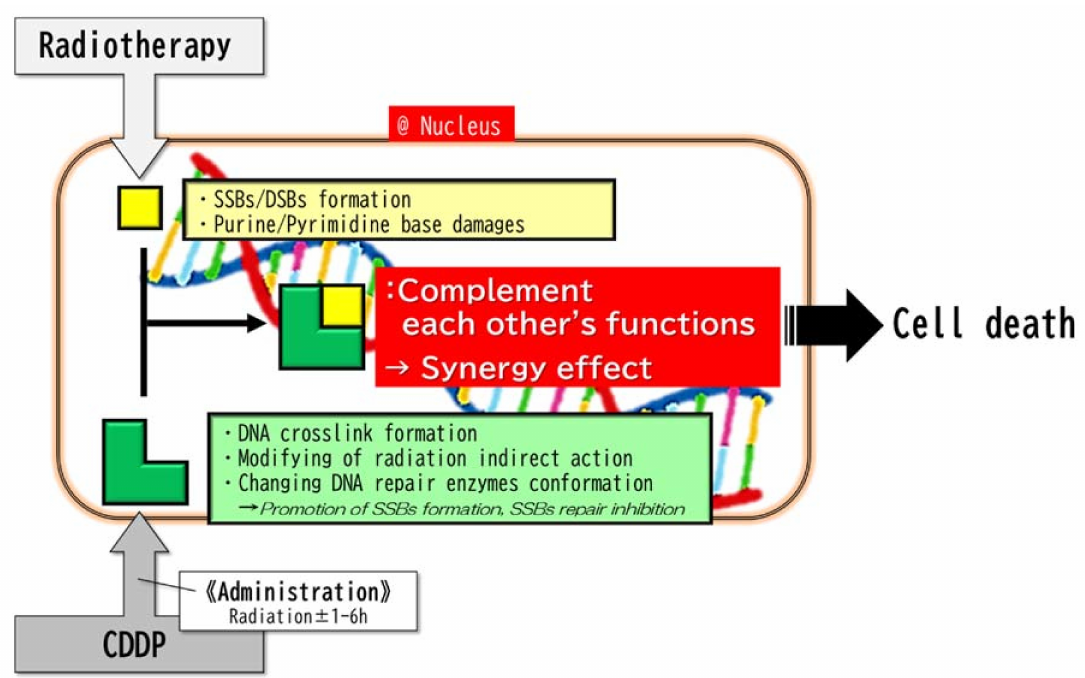
Figure 3. Minor reactions. The minor reactions take place in the nucleus. The complementary combination of radiation- induced primary DNA strand breaks and CDDP-induced DNA damages (DNA crosslink, etc.) synergistically results in DNA damage and then cell death. Since the crosslinks of DNA by CDDP are metabolized in a few hours, it may be necessary to perform RT within a few hours after the administration of CDDP in order to obtain a sufficient synergistic effect. Abbreviations: SSBs, single-strand breaks; DBSs, double-strand